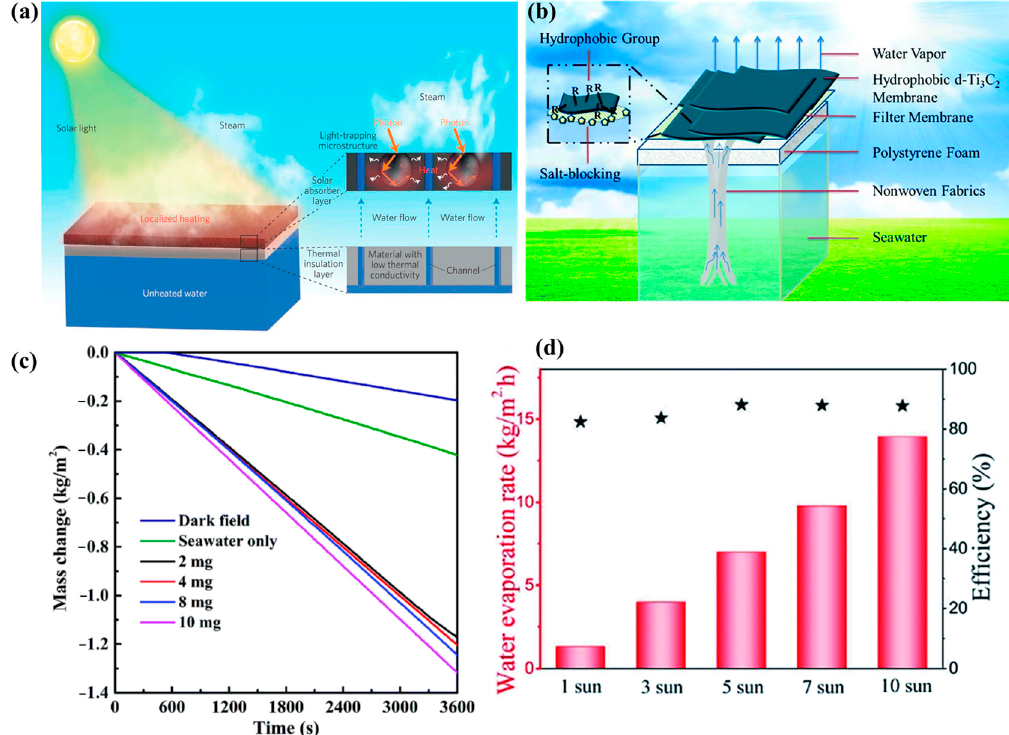
Figure 13. ( a ) Illustration of the representative DSSG process, including a solar absorber layer, a thermal insulator layer, and water transport channels [126]. ( b , c ) Schematic of the hydrophobic Ti 3 C 2 membrane-based solar desalination device and real-time seawater weight loss through the evaporation of the hydrophobic D-Ti 3 C 2 membrane with different loading masses [129]. ( d ) Water evaporation rates (left-hand side axis) and the corresponding solar steam efficiencies of the 3DMA-5 system under solar illumination of different intensities [127].